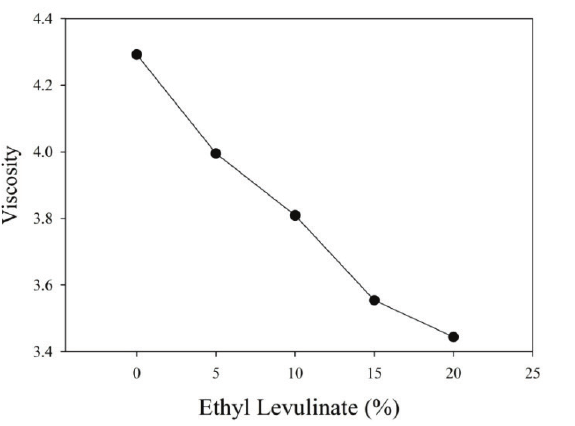
Figure 2: Effect of ethly levulinate amount on the viscosity of the fuel